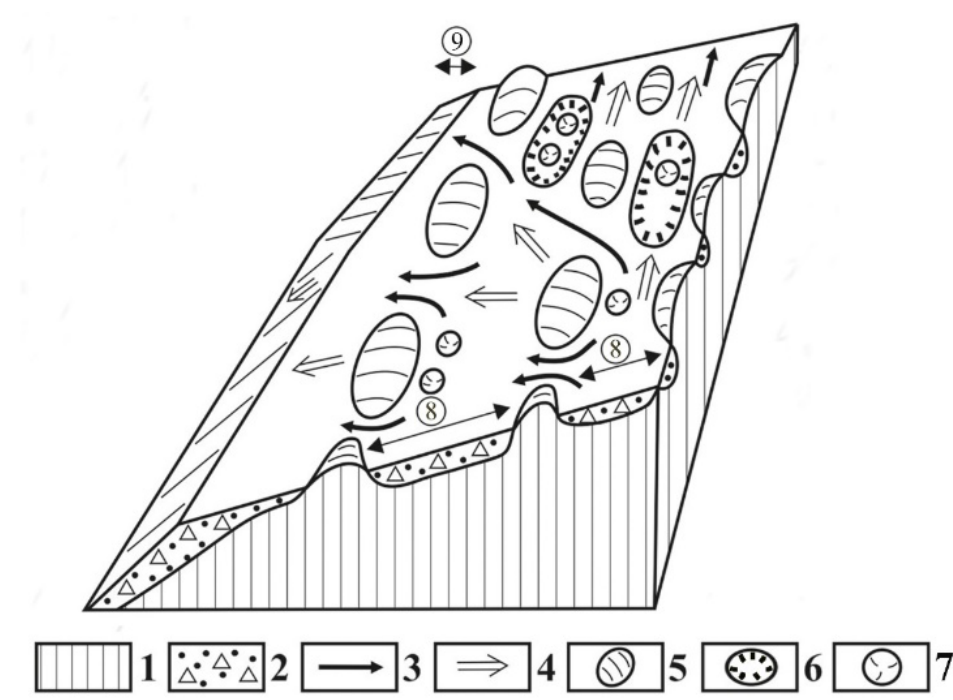
Figure 9. Karstification of a block dissected by limestone mounds if the block and its surface are inclined in two directions, one of the directions is parallel with the surrounding and sediment recipient valley. 1. limestone, 2. superficial deposit and limestone debris, 3. surface denudation by pluvial erosion and its direction, 4. dip direction of the surface, 5. exhumed limestone mound, 6. depression of superficial deposit, 7. subsidence doline, 8. lower plain (or low-inclined) surface of superficial deposit between cones, 9. valley, valley side.